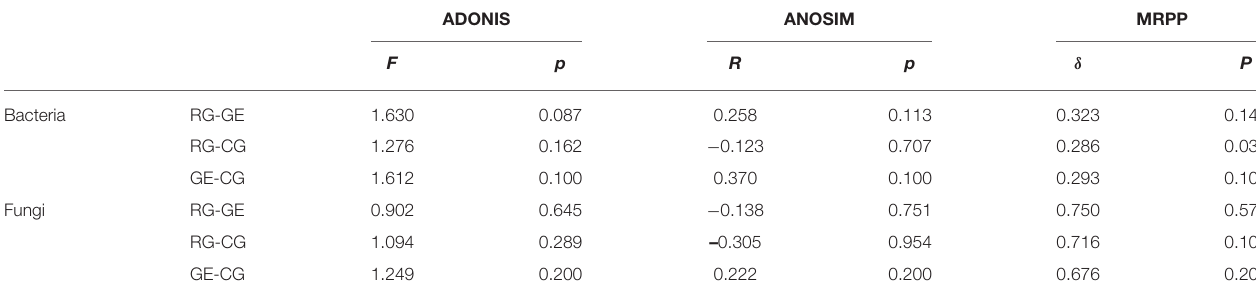
TABLE 1 | Nonparametric analyses to test the dissimilarity of the soil microbial communities among the grazing regimes. ADONIS ANOSIM MRPP F p